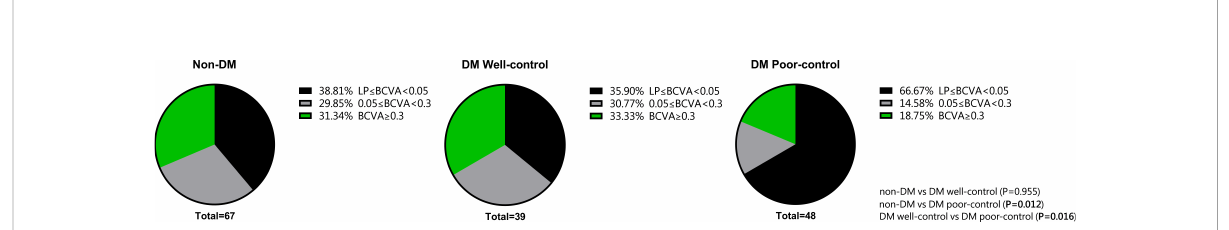
FIGURE 5 The Best-corrected Visual Acuity (BCVA) Distribution of Acute Angle Closure Crisis (AACC) Eyes in Three Study Group DM, diabetes mellitus. Bolded values indicate statistically signi fi cant. The blindness grade of BCVA in DM poor-control patients accounted for 66.67%, which was statistically signi fi cant compared to that of the non-DM group and DM well-control group.